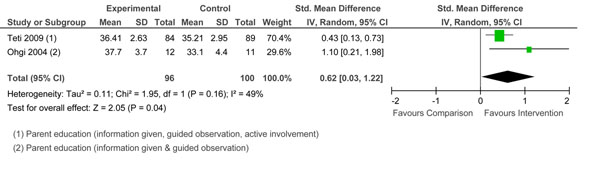
Forest plot of comparison: 1 Group, outcome: 1.4 Self-Efficacy.